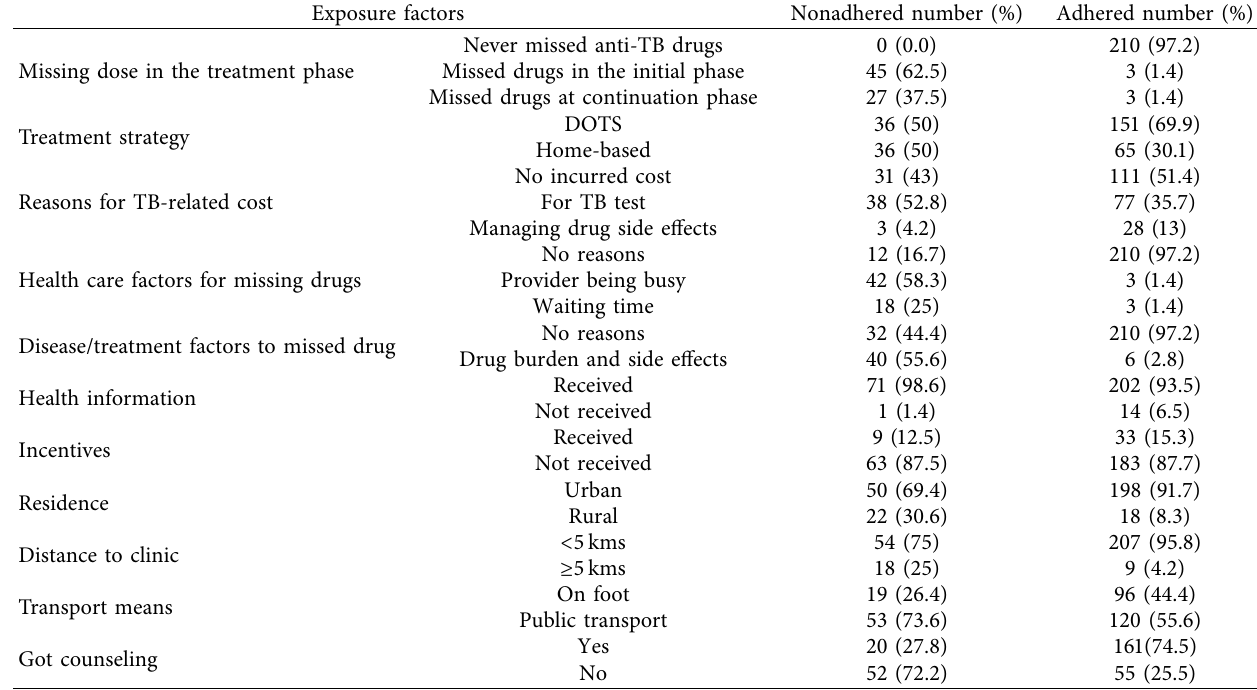
Table 4: HCWs and healthcare provider-related factors in relation to TB-drug nonadherence in Gambella region. Exposure